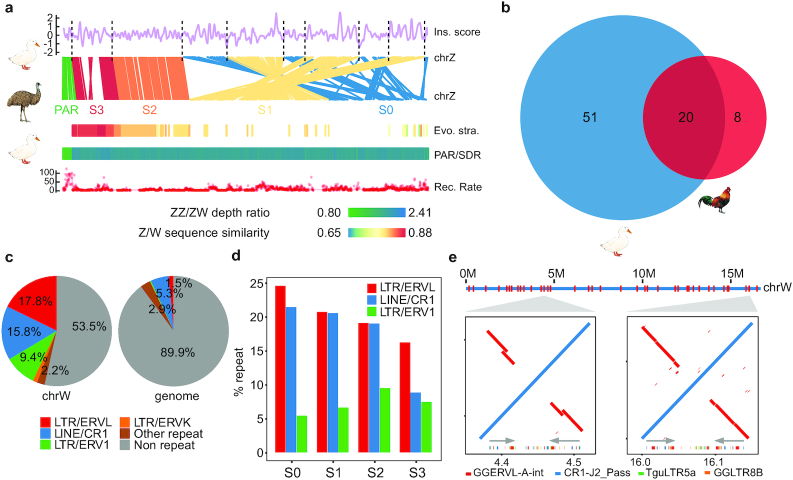
Sex chromosome evolution in Pekin duck. a, Evolutionary strata analyses of the duck sex chromosomes. From top to bottom: the breakpoints of genomic rearrangements (dashed lines) between emu and duck chrZ tend to have a lower insulation score; gene synteny between the emu and duck Z chromosomes; alignment of the duck chrW scaffolds against the emu chrZ reveals a pattern of evolutionary strata, with each scaffold showing the color-scaled sequence divergence levels between the duck chrW vs the emu chrZ; PAR (light green)/SDR (dark green) composition inferred by the ratio of male vs female Illumina DNA sequencing depth with the color scaled to the ratio value; a higher recombination rate in the duck PAR than in SDR. b, Scaled Venn diagram shows the chrW genes shared between duck and chicken. c, Comparing the repeat content of the duck chrW to the whole genome. d, Different enrichment trends of chrW repeats at different evolutionary strata. e, Palindrome structure of duck chrW. Palindromes are labeled across the entire chrW (red), ordered according to the duck chrZ. Shown are alignment plots of 2 zoomed-in examples of palindromes (red inversions and grey arrows) for their repeat content (colors below grey arrows). LINE: long interspersed nuclear element; LTR: long terminal repeat.